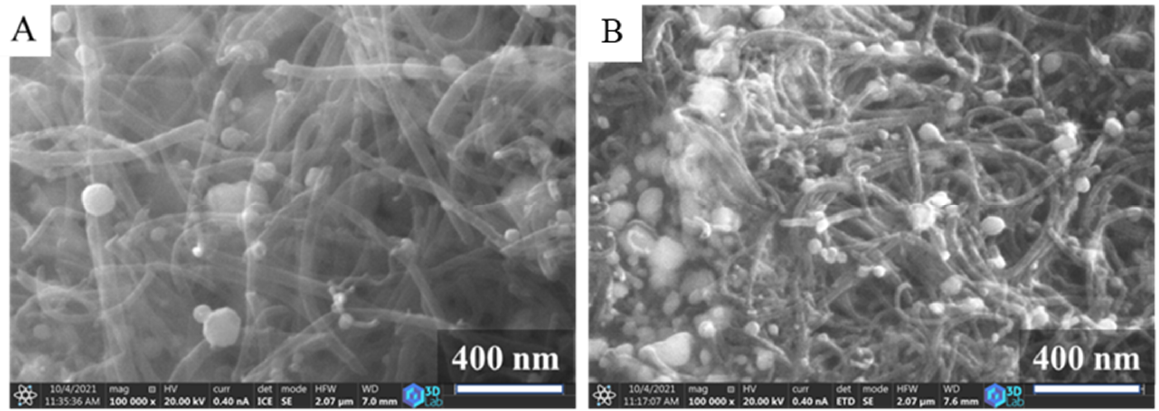
which contain not only the residual Ni from the CCVD synthesis, but also Ni and Fe particles that have replaced Na from Na-alginate.